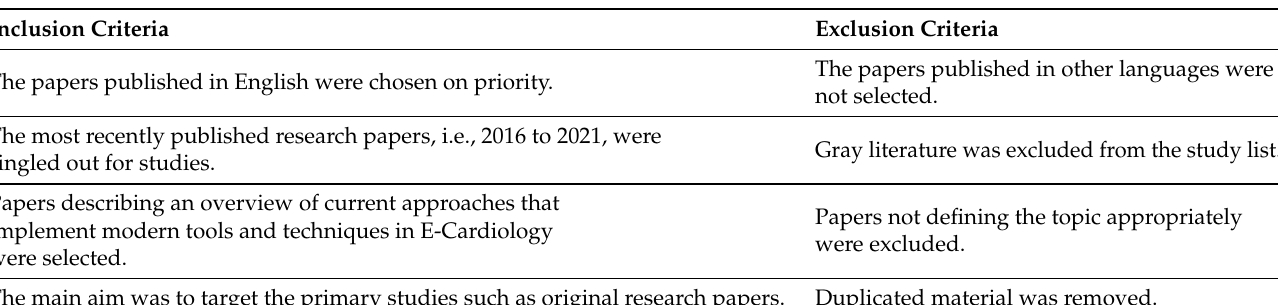
Table 4. Inclusion and exclusion